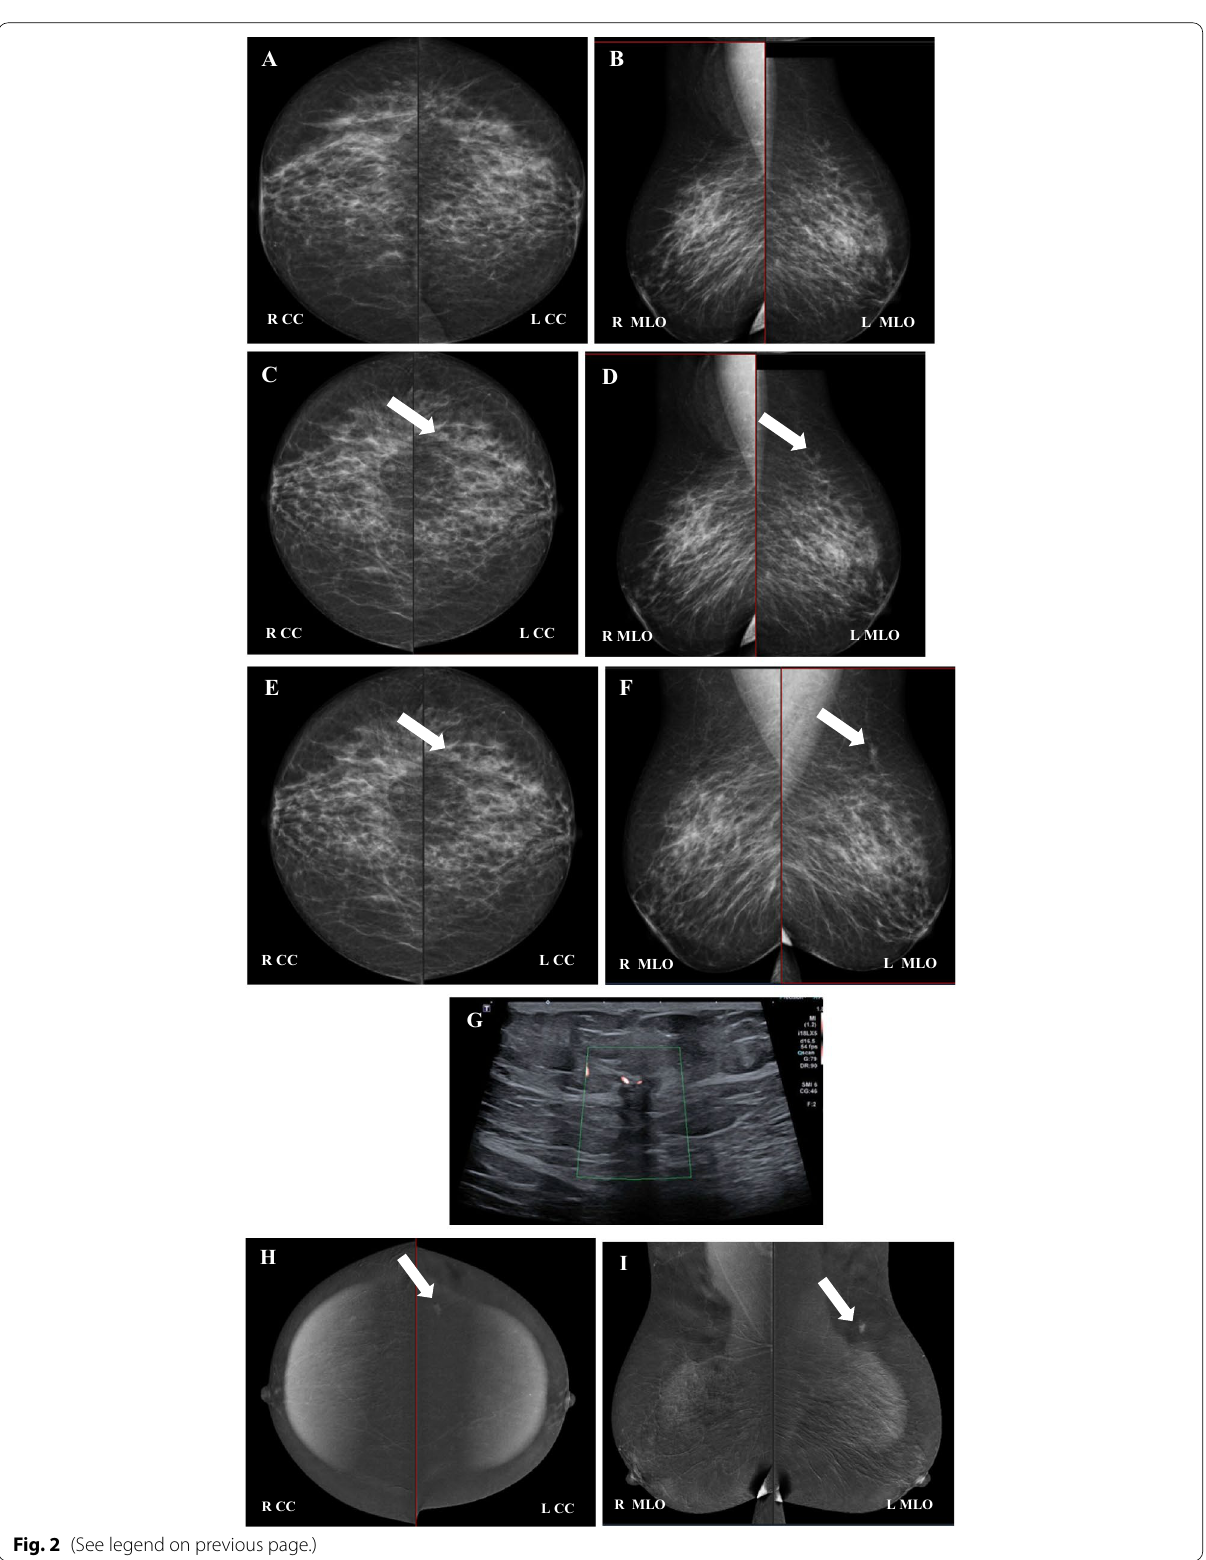
Fig. 2 (See legend on previous